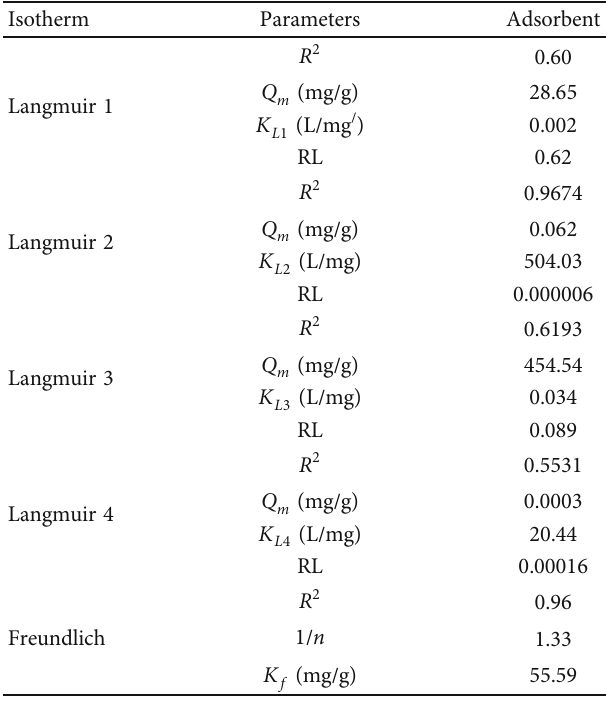
Figure 7: Langmuir isotherm for RR2 adsorption on GWAC (a) type 1 Langmuir, (b) type 2 Langmuir, (c) type 3 Langmuir, and (d) type 4 Langmuir at ( pH = 7 , contact time = 50 min , dye concentration = 300 mg/L ). Table 5: Isotherm model parameters and correlation coe ffi cients for RR2 adsorption on